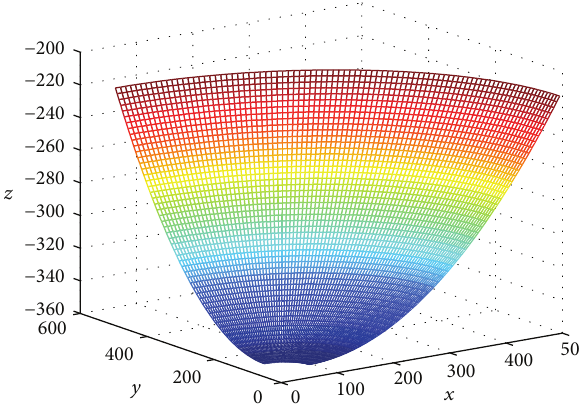
Figure 4: Designed model given by Matlab.